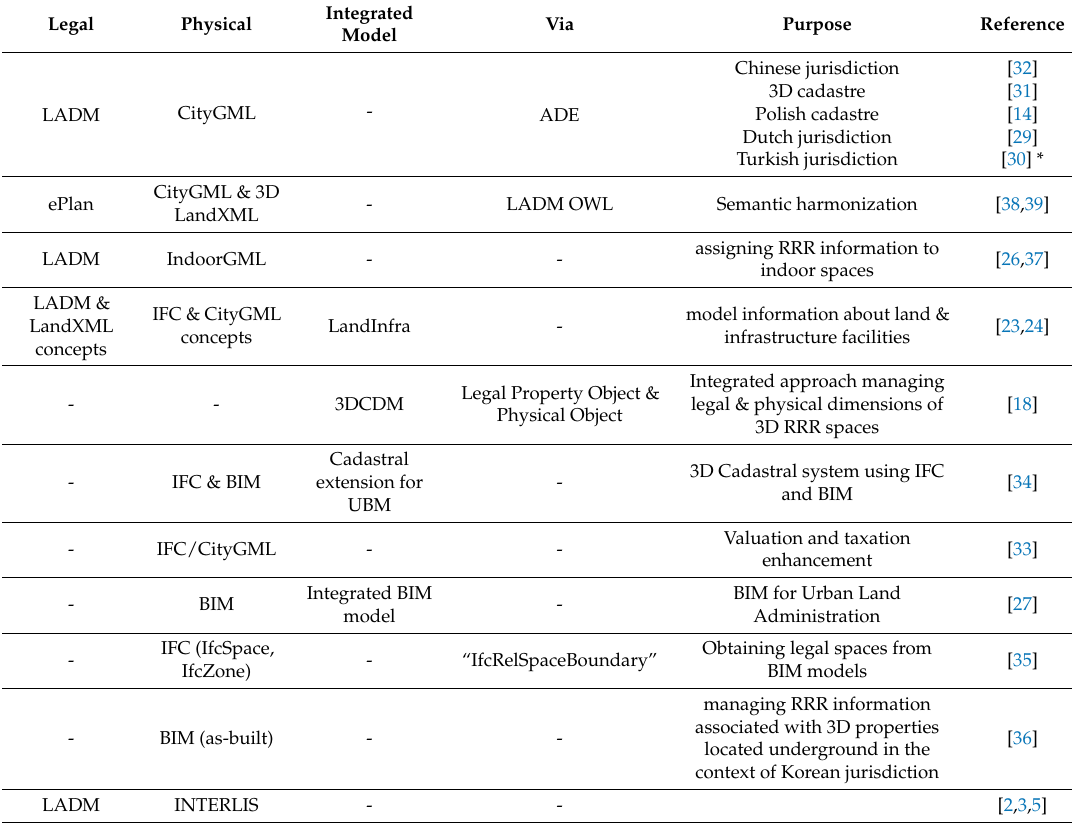
Table 1. Legal and physical integration